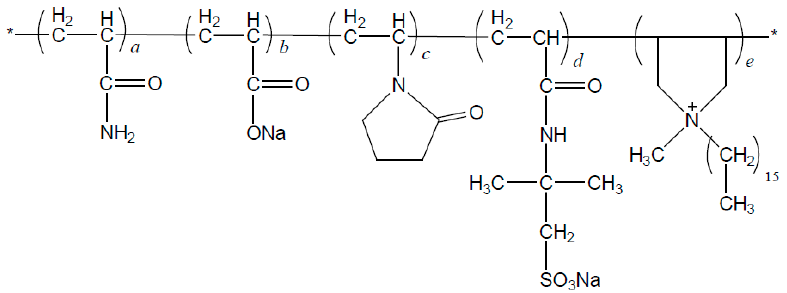
Figure 2. Structural schematic diagram for the target polymer.